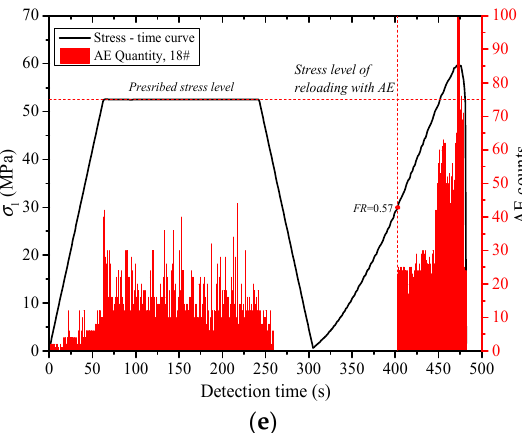
Figure 4. Stress–time–AE curves in uniaxial cyclic loading and unloading test of red sandstone under different stress levels. ( a ) σ A = 0.5 σ c ; ( b ) σ A = 0.6 σ c ; ( c ) σ A = 0.7 σ c ; ( d ) σ A = 0.8 σ c ; ( e ) σ A = 0.9 σ c .